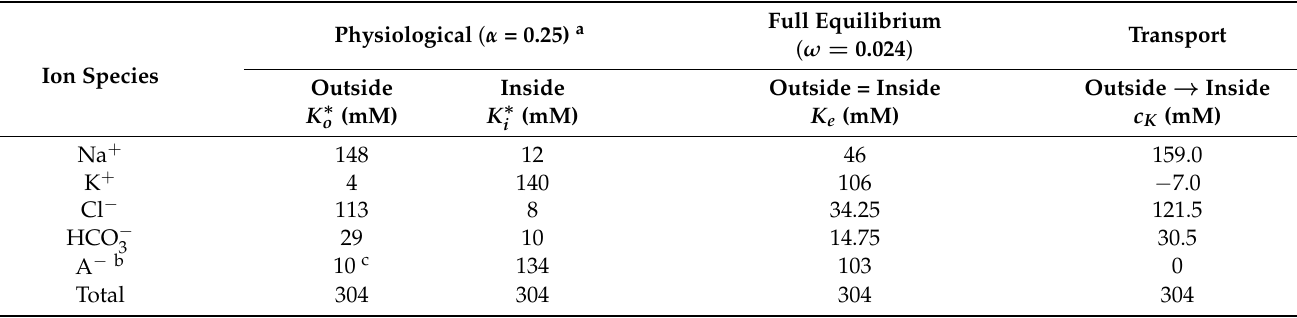
Table 1. Extra- and intraneuronal ion concentrations before and after